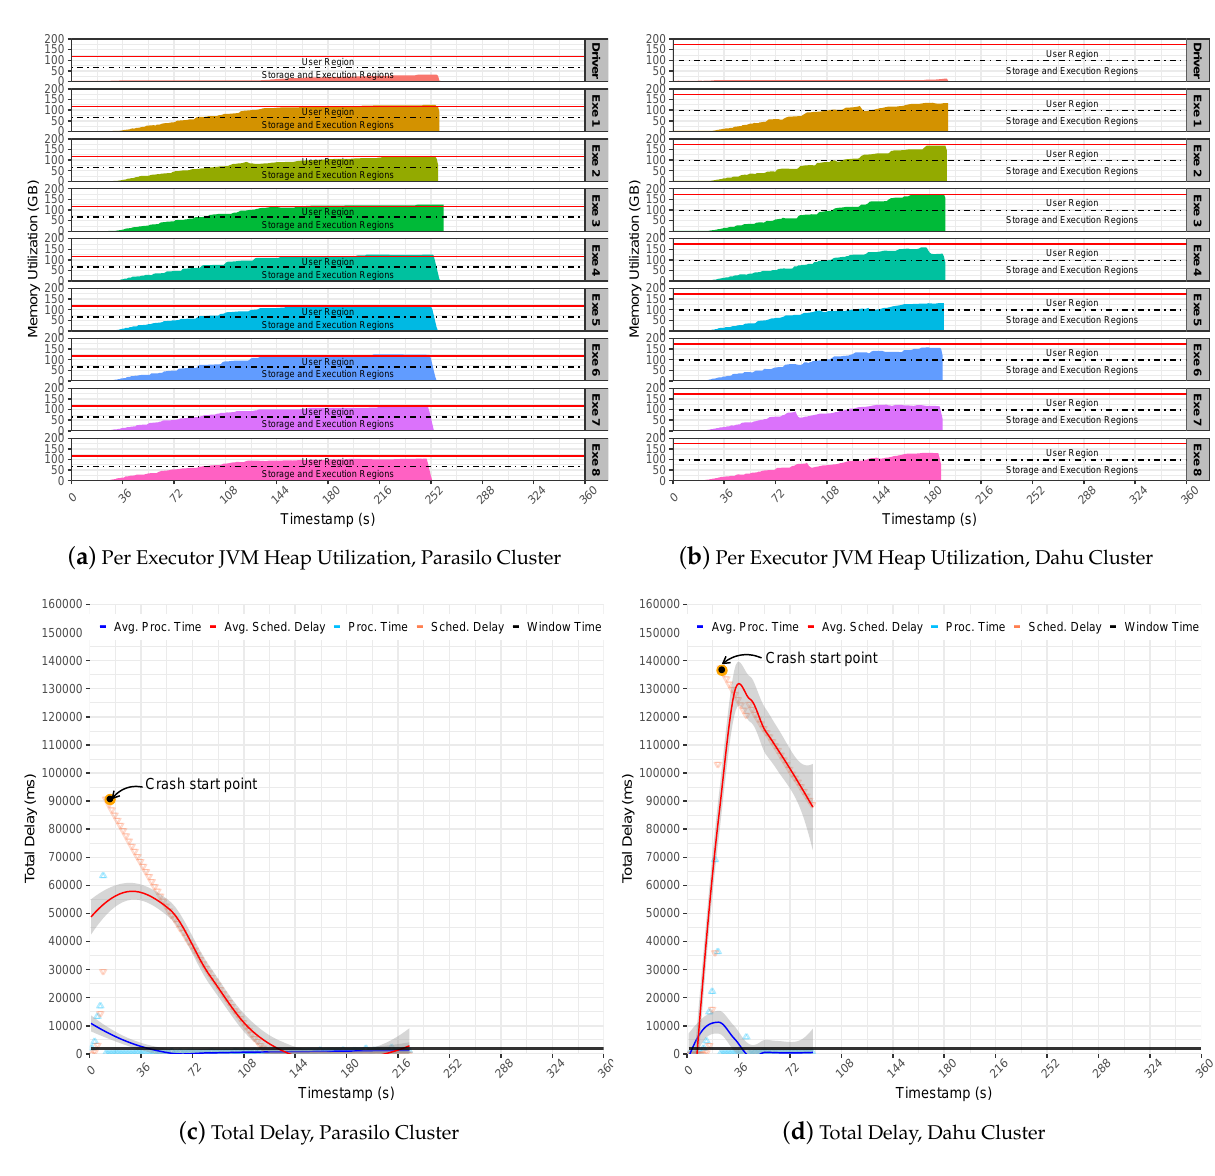
Figure 7. Stateful SumServer Application Without Backpressure—Pipeline